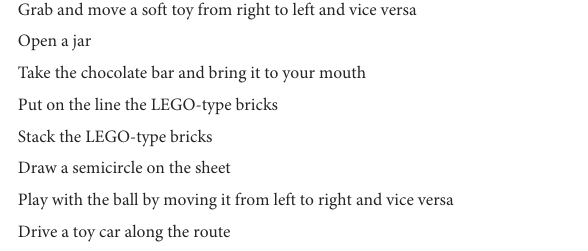
TABLE 2 List of actions presented through video clips and seen by children in the MI task. Action Grab and move a soft toy from right to left and vice